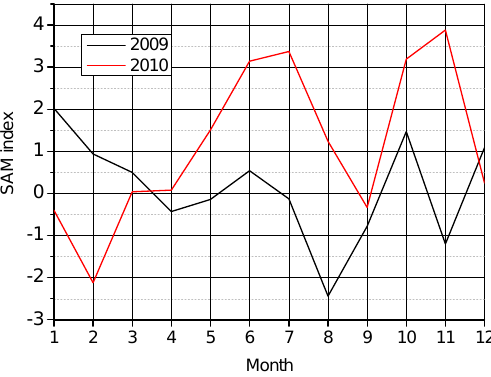
Figure 8. Mean monthly SAM index for 2009 and 2010 (after Mar- shall,